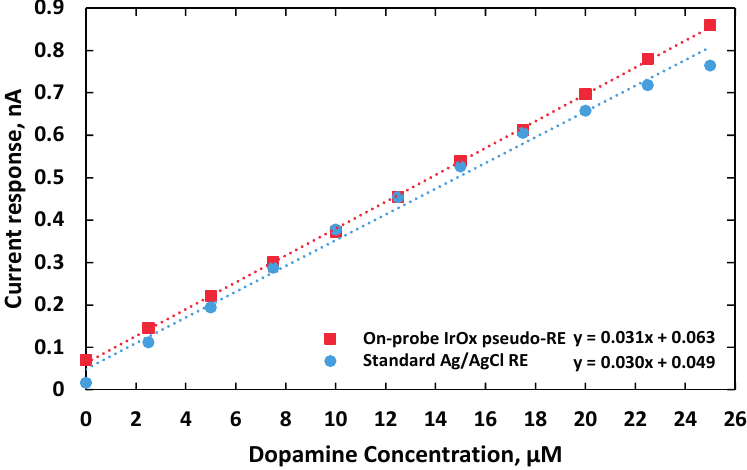
Figure 10. Sensitivities of (red) the DA sensor with integrated IrO x WE and IrO x pseudo-RE on the same probe; and (blue) the DA sensor that employed a gold WE and an external commercial glass-tube Ag/AgCl RE